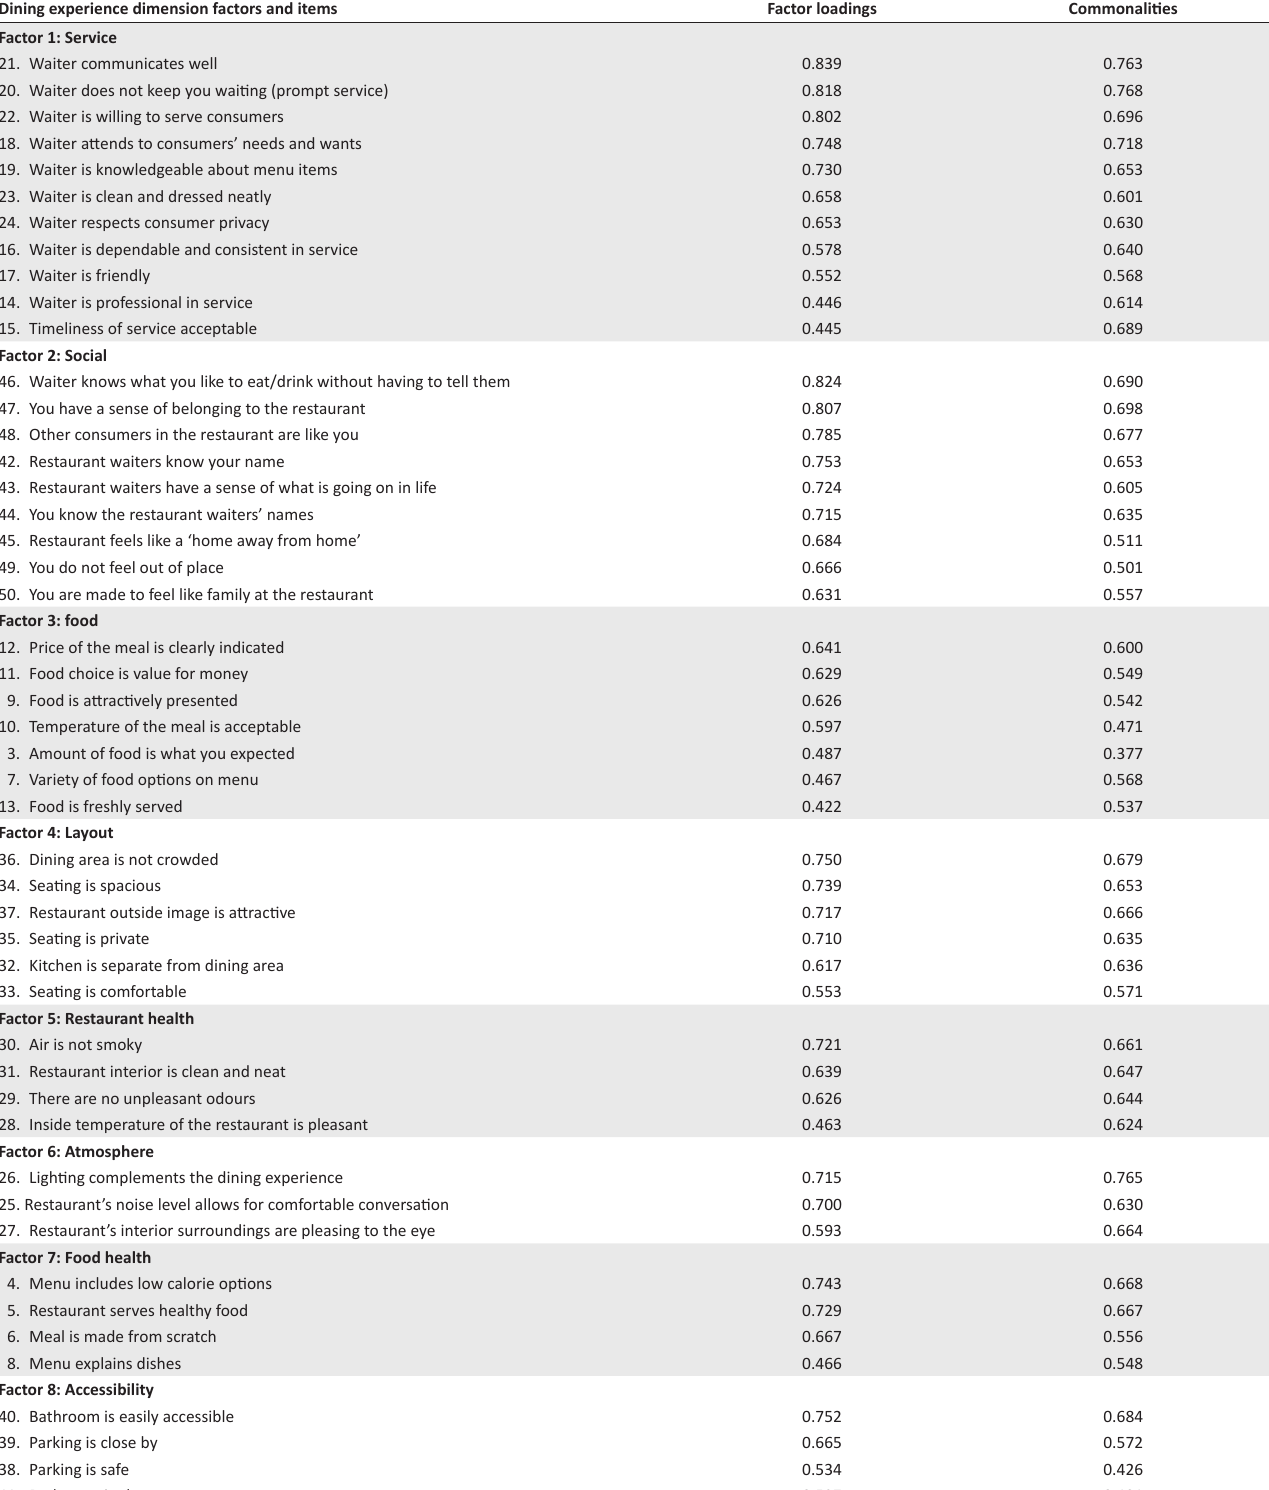
TABLE 2: Exploratory factor analysis for the reduced list of 48 dining experience dimension items (eight-factor solution) ( n = 363). Dining experience dimension factors and